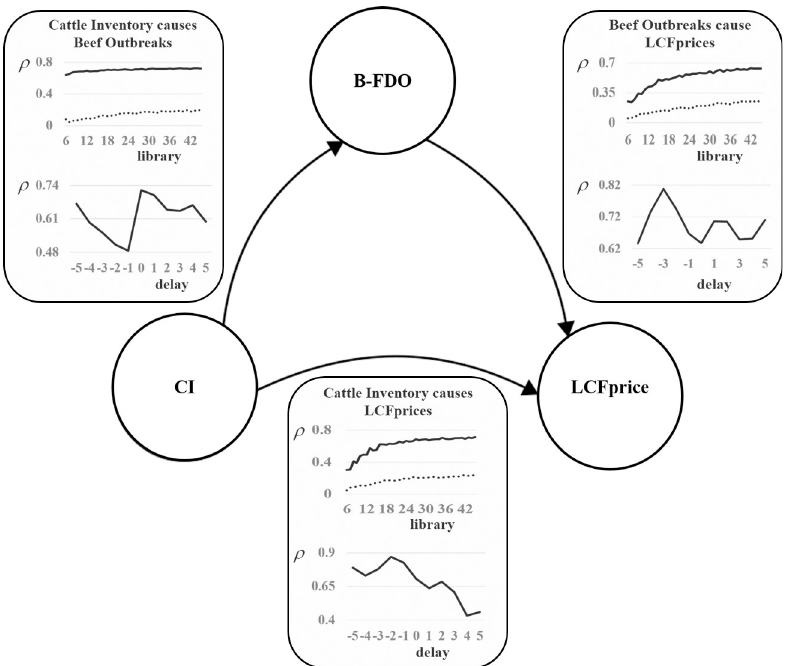
Fig 4. Causality detection. Pairwise causal interactions passing both CCM and Extended-CCM detection are summarized in a causal network diagram in which circular hubs depict interactive signals and incoming arrows denote driving interactions. Evincing market response, LCFprice is driven by both B-FDO and CI. Evincing transmission of FDOs attributed to beef from ‘farm to fork’, CI drives B-FDO. The plots adjacent to each arrow display results of corresponding CCM (top) and Extended-CCM (bottom) tests. Each detected interaction is moderately strong since CCM curves (black curve) converge to a correlation coefficient ρ of at least 65%, and statistically significant since it rests above a bootstrapped 95% lower confidence bound (dashed curves). The Extended-CCM curve for each cross mapping peaks at non-positive delays, ruling out false-positive noncausal sychronous interactions.